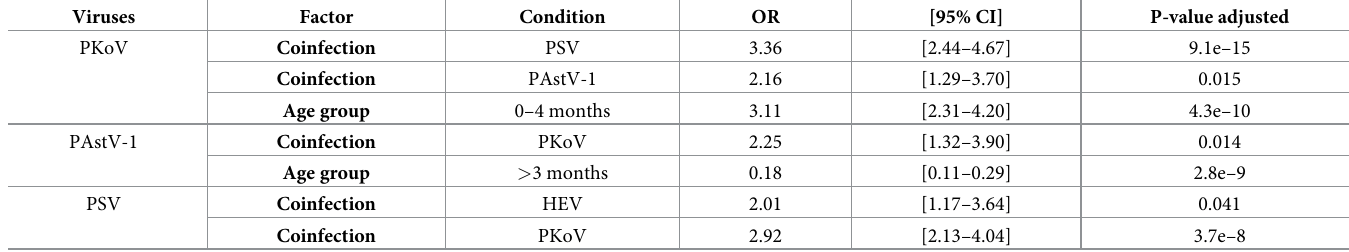
Table 4. Statistical analysis of factors associated with each virus (multivariate logistic regression model with random effect at the farm level).